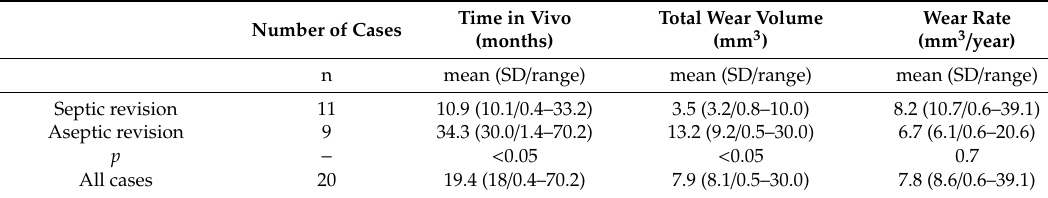
Table 2. Total wear volume, time in vivo and wear rates of MoM couplings, subclassified into septic and aseptic